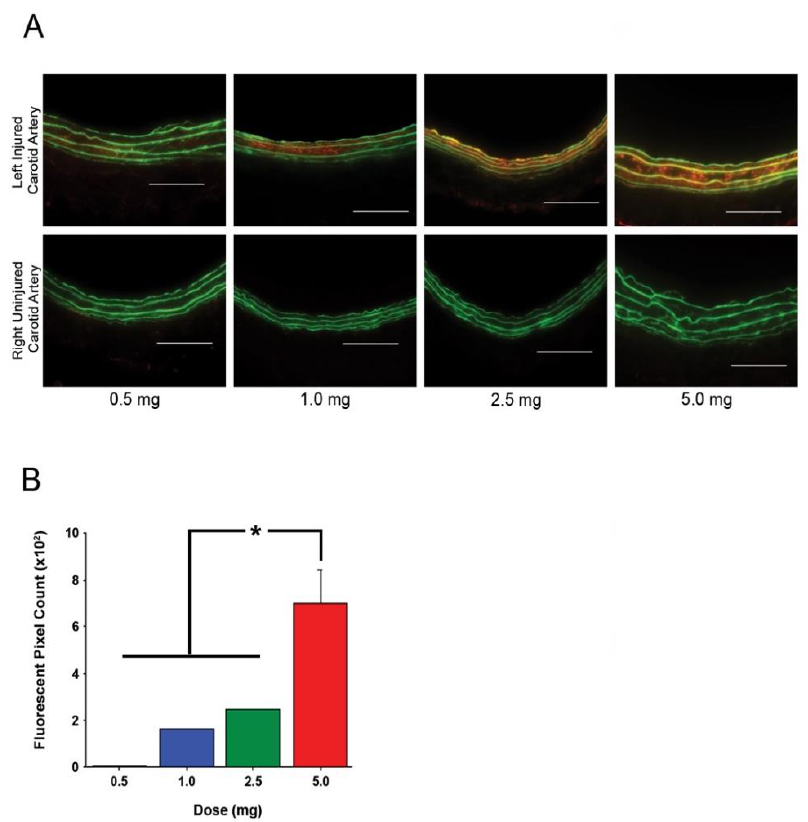
Figure 4. Fractalkine-targeted nanofiber exhibits dose-dependent localization at the left injured carotid artery without localizing to the right uninjured carotid artery. ( A ) Fluorescent signal of fractalkine-targeted nanofiber to injured carotid artery is increased with increasing doses of peptide amphiphile injection. Green = autofluorescence of arterial lamina and red = TAMRA-tagged nanofiber. Magnification, 20 ; n = 3; scale bar = 100 µm. ( B ) Quantification of fluorescence demonstrates localization of fractalkine-targeted PA to the injured artery increases with increasing amounts of PA injection, * p < 0.05.